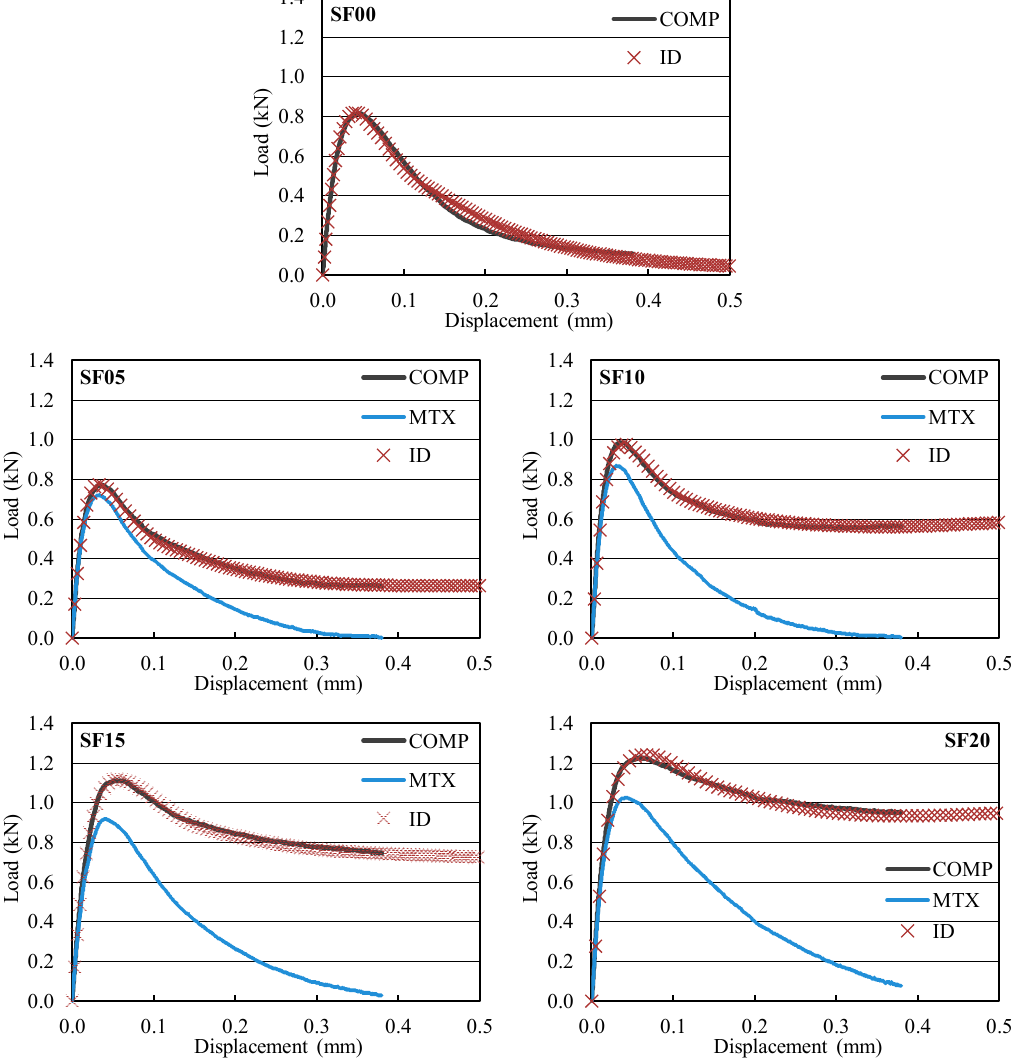
Figure 5. F–d diagrams for selected specimens of individual AAS composites with various amounts of steel microfibers: COMP—a measured diagram of composite reinforced by microfibers; MTX—a simulated diagram corresponding to the plain AAS matrix; ID—an identified diagram of composite reinforced by microfibers.